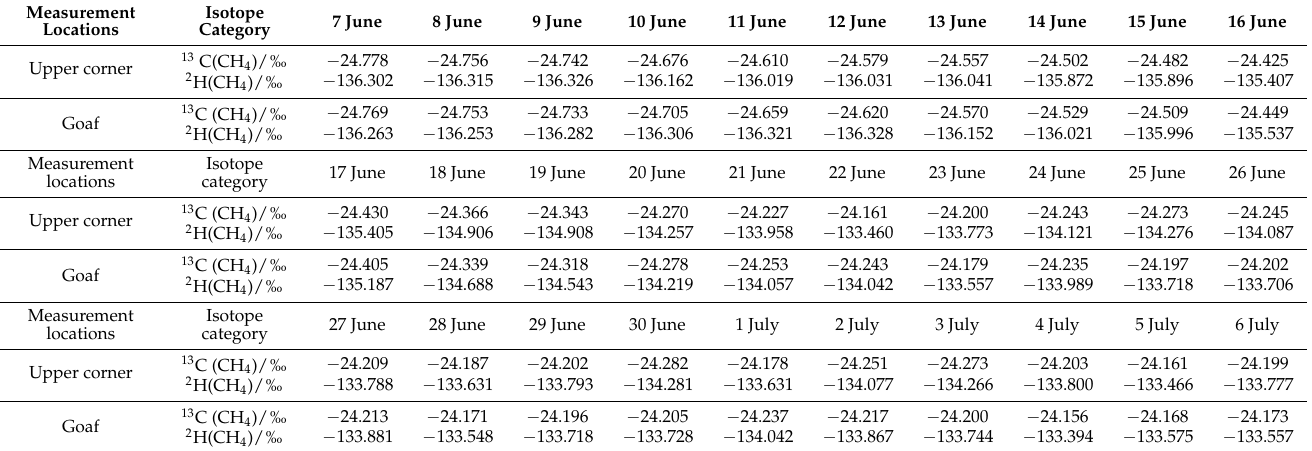
Table 2. Test results of CH 4 hydrocarbon isotope value in the mixed gas of the working face.